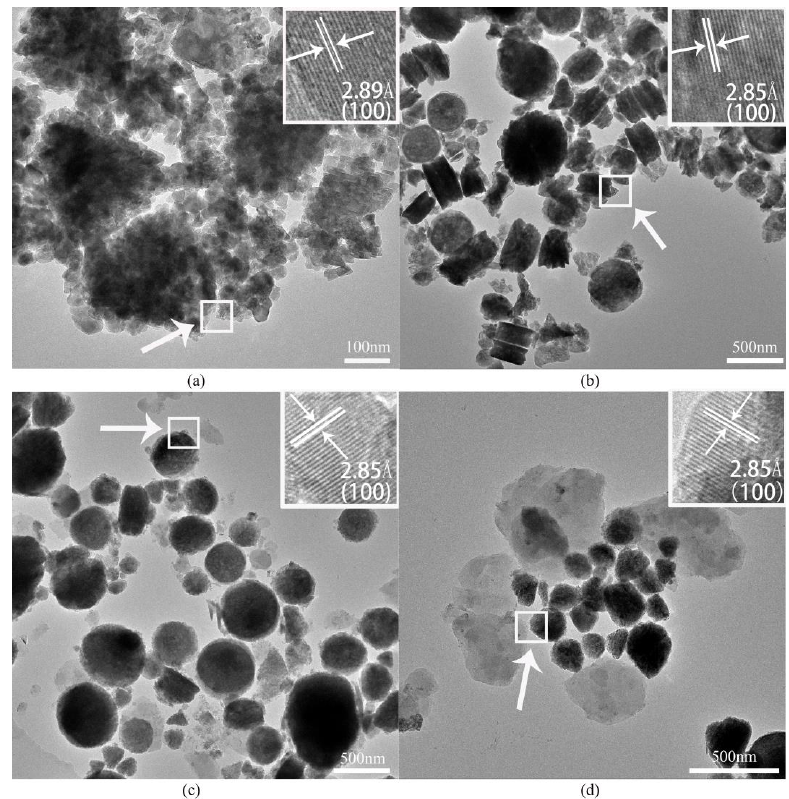
Figure 4. Typical transmission electronic microscopy (TEM) images of ( a ) pure ZnO, ( b ) Zn 0.7 Mg 0.3 O, ( c ) Zn 0.68 Mg 0.3 B 0.02 O, and ( d ) Zn 0.66 Mg 0.3 B 0.04 O nanoparticles.